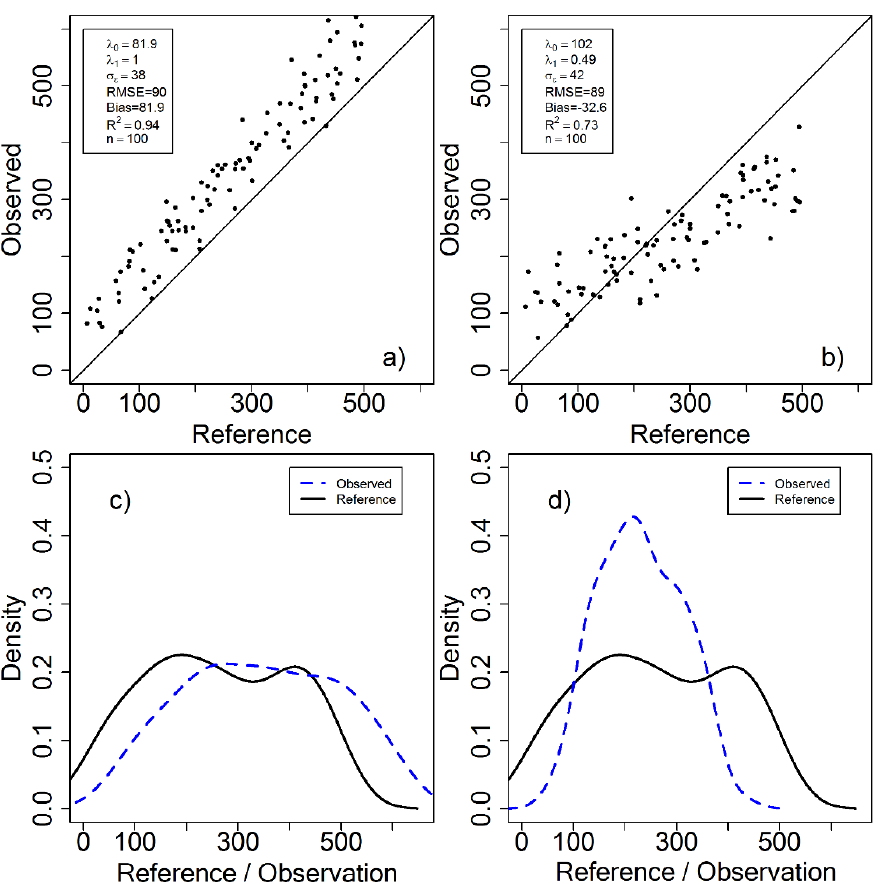
ff erent error structure, as illustrated Figure 3. Two cases ( a , b ) have approximately the same RMSE but different error structure, as Figure 3. Two cases ( a , b ) have approximately the same RMSE but di in the scatterplots. The two cases can also be described with density curves ( c , d ). In ( a ), there is a constant systematic error, with λ 0 = 81.9 and λ 1 = 1 implying a positive shift from the 1:1 line. In ( b ), there is a varying systematic deviation due to λ 1 (cid:44)